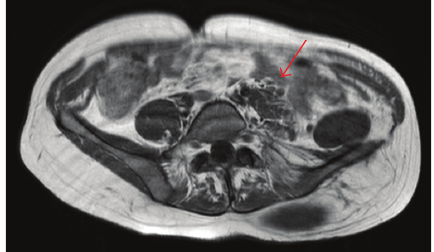
Figure 3: MRI scan showing the retroperitoneal NF1 lesion (arrow) at the bleeding site. Lateral displacement of left psoas muscle due to tumour